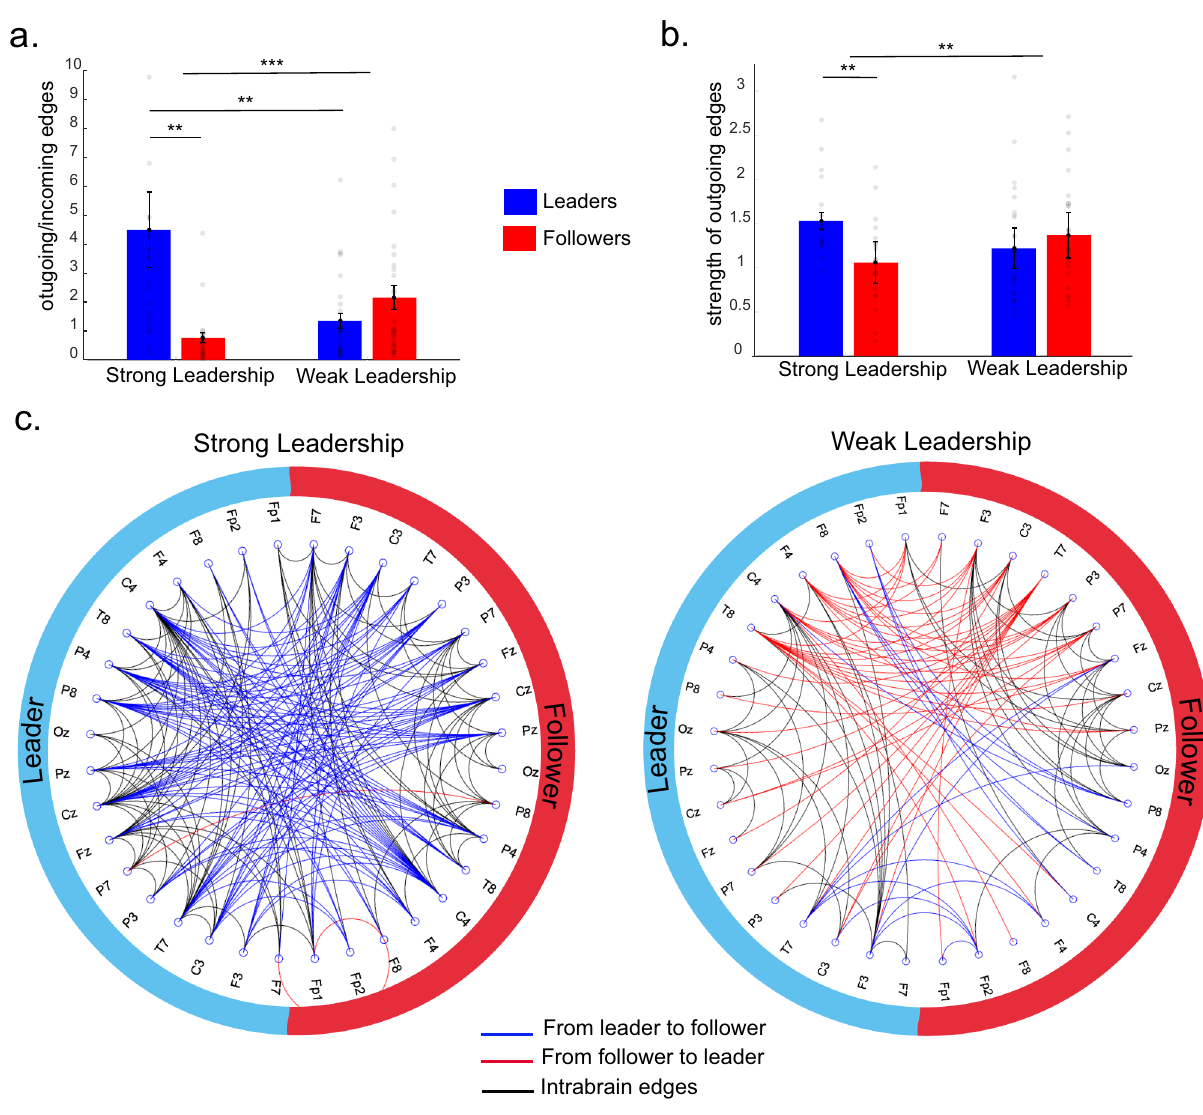
Fig. 7 Directed connectivity (PSI) during eye-to-eye. a Proportion of inter-brain outgoing in relation to incoming edges in leaders (blue) and followers (red) during eye contact in pairs with strong and weak leadership. The shaded dots represent each individual datapoint in each condition ( n = 96 valid datapoints). Data for two leaders in a strong leadership dyad are not displayed to keep the data visible (datapoint 1 = 17.86/ datapoint 2 = 22.33). b Strength of inter-brain outgoing edges in leaders and followers during EC in pairs with strong and weak leadership ( n = 96 valid datapoints). c Circular display of the intra and inter-brain networks during eye contact for pairs with strong (left-hand side) vs. weak (right-hand side) leadership strength. The blue edges represent connections from leader (left) to follower (right); the right edges represent connections from follower to leader; black represents intra-brain edges. These measures are based on the networks thresholded at 1 SD against the control task. Error bars represent ±1 SEM. *** p < 0.001/** p < 0.01/ * p <